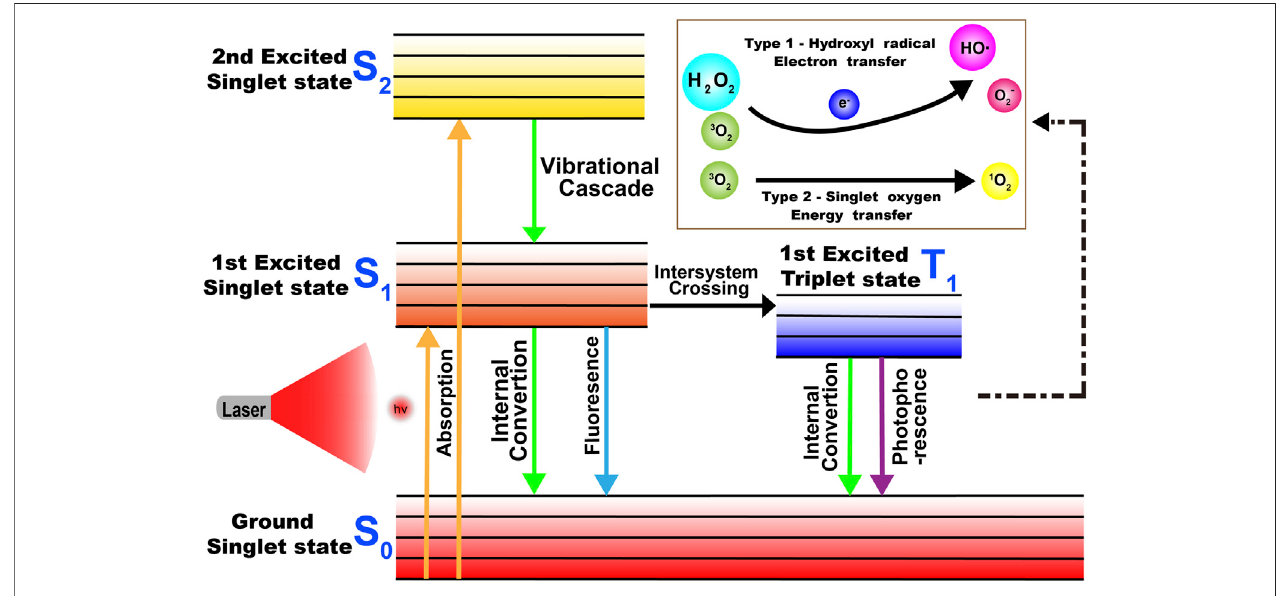
FIGURE 4 | Mechanism of the production of ROS in